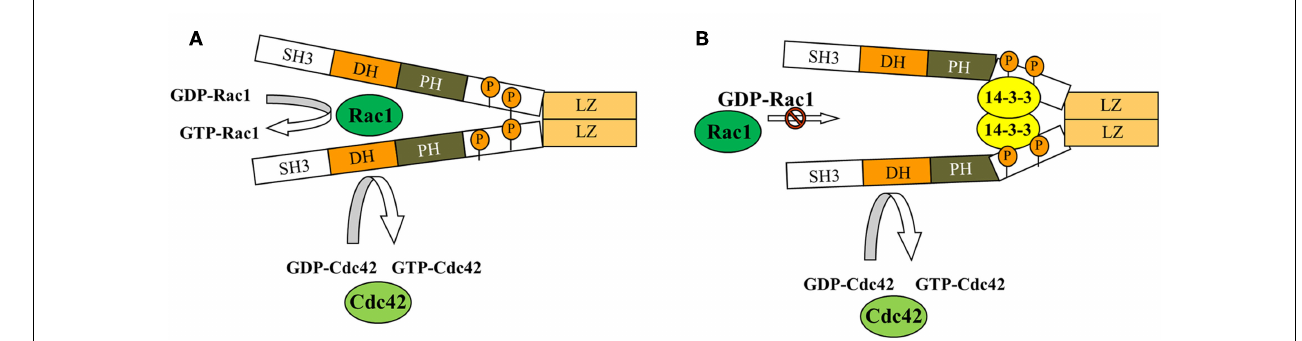
FIGURE 4 | Model depicting how binding of 14-3-3 inhibits dimeric β 1 Pix-GEF activity. Model depicting how binding of 14-3-3 β 1 Pix-GEF activity. (A) Under basal conditions, the binding of 14-3-3 is minimal and does not affect its GEF activity. (B) In the presence of agonist, binding of 14-3-3 β to β 1 Pix through S516 andT526 is increased. 14-3-3 β binding may either block the interaction between Rac1 and the DH domain